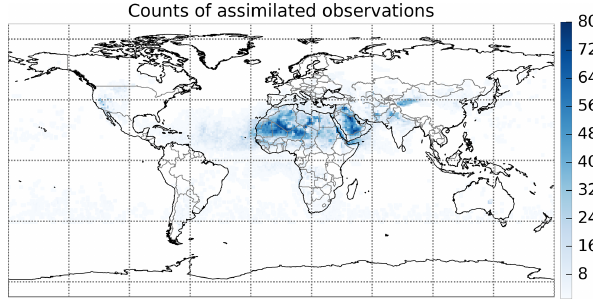
Figure 4. Number of NRL MODIS and MODIS Deep Blue Level 3 observations assimilated between May and August